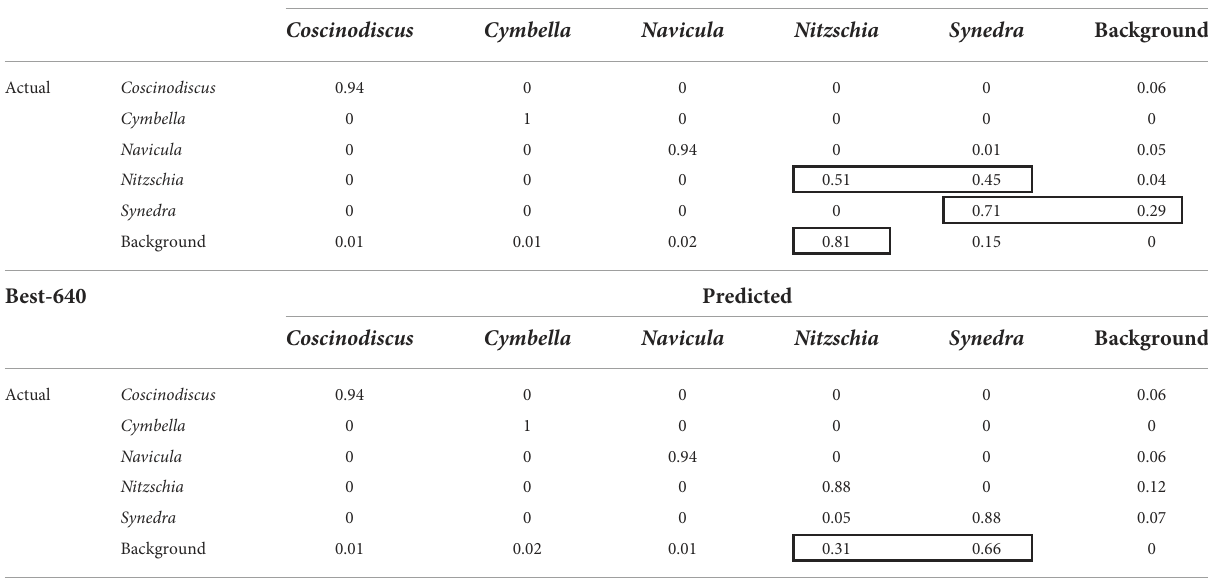
TABLE 4 The confusion matrices derived from the multi-class recognition of the lab-grown diatoms with the Last-640 and Best-640 models.